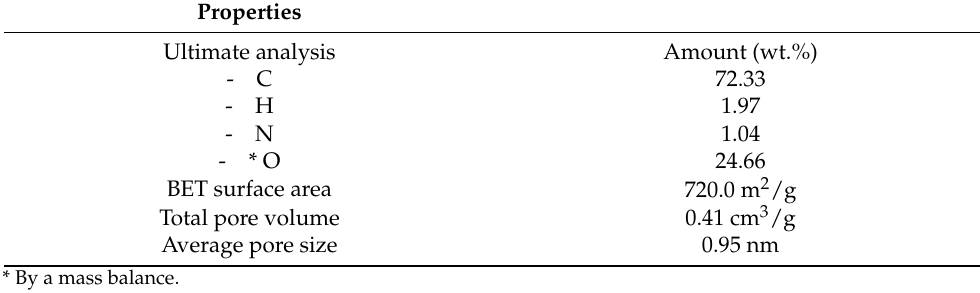
Table 3. The characteristics of activated carbon.